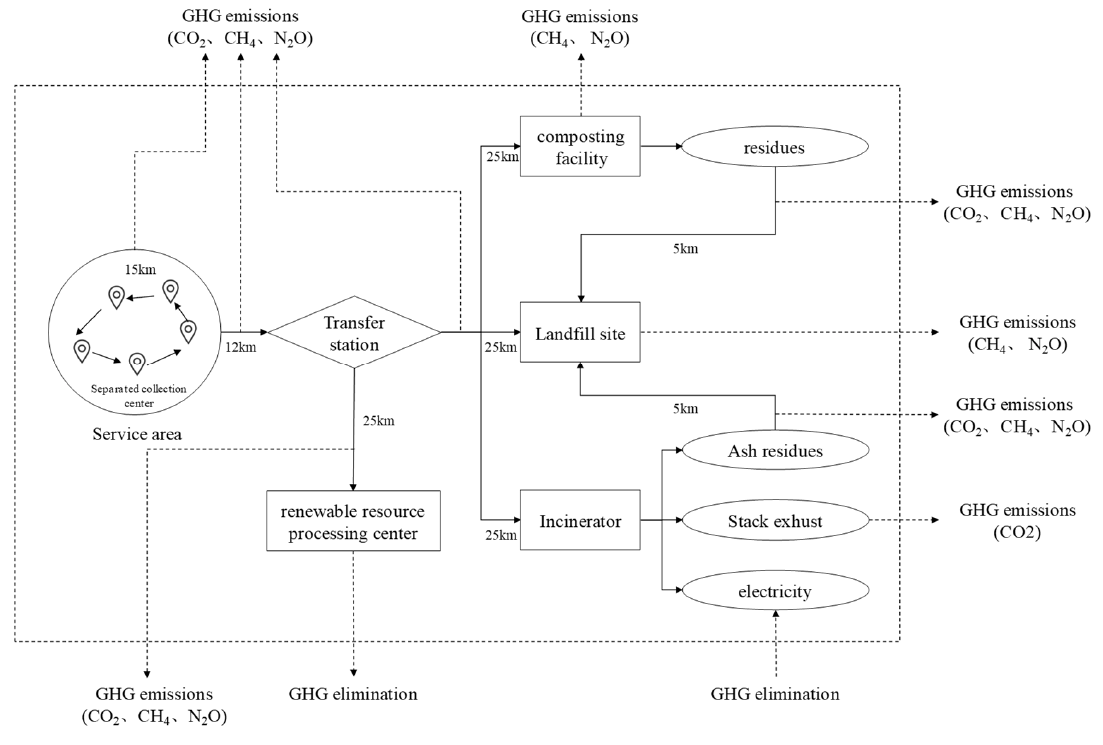
Figure 5. GHG emissions evaluation boundary in Scenario 4.